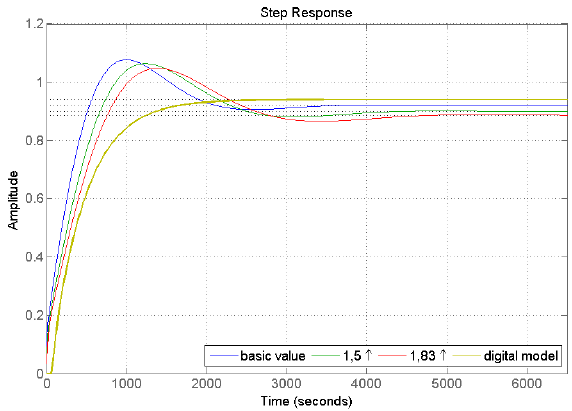
Figure 8. Segment G2 step responses for simulation of changes in diameter of flow channel.